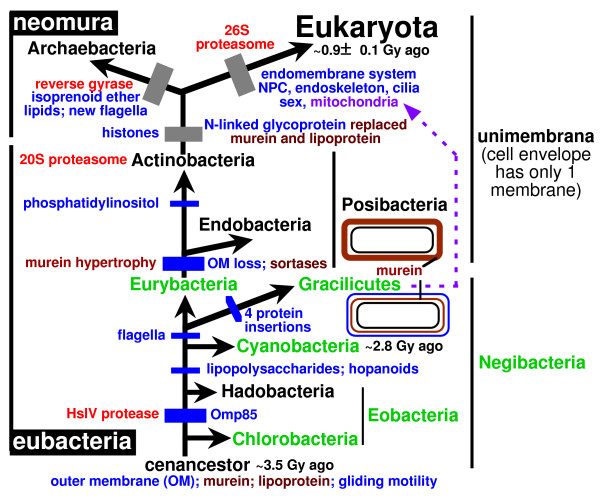
Simplified summary of the 10 major cellular transitions in the history of life. Those discussed and polarized previously [1, 27, 33] are shown by grey bars, while those discussed in detail here for the first time have blue bars; the five shown by thick bars plus the origin of 20S proteasomes (within actinobacteria, so no bar) are especially decisively polarized; evolution in the reverse direction would have been highly improbable, whereas for the four shown by narrow blue bars evolution in the reverse direction would have been mechanistically possible but unparsimonious and have required numerous losses. Evolutionary loss has, however, sometimes played a crucial role, as in the origins of posibacteria and of neomura by the loss of the OM and murein wall respectively. The bacterial groups shown in green are either all photosynthetic (Cyanobacteria) or have a mixture of phototrophs and heterotrophs (the others); the entirely non-photosynthetic bacterial groups are in black. The fundamental changes involving murein peptidoglycan are shown in brown. NPC = nuclear pore complexes, several proteins of which are structurally related to those of coated vesicles, all probably arising in a single burst of gene duplication during the origin of eukaryotes [199]. The dotted line from Gracilicutes to mitochondrion signifies the intracellular enslavement of a probably photosynthetic purple bacterium by a protoeukaryote to make the chimaeric eukaryote cell [33, 129], which must have taken place long after the origin of proteobacteria, even longer after the origin of Gracilicutes and eubacteria, but probably only shortly after the neomuran revolution and bifurcation into archaebacteria (the youngest of all bacterial phyla) and the preeukaryote.